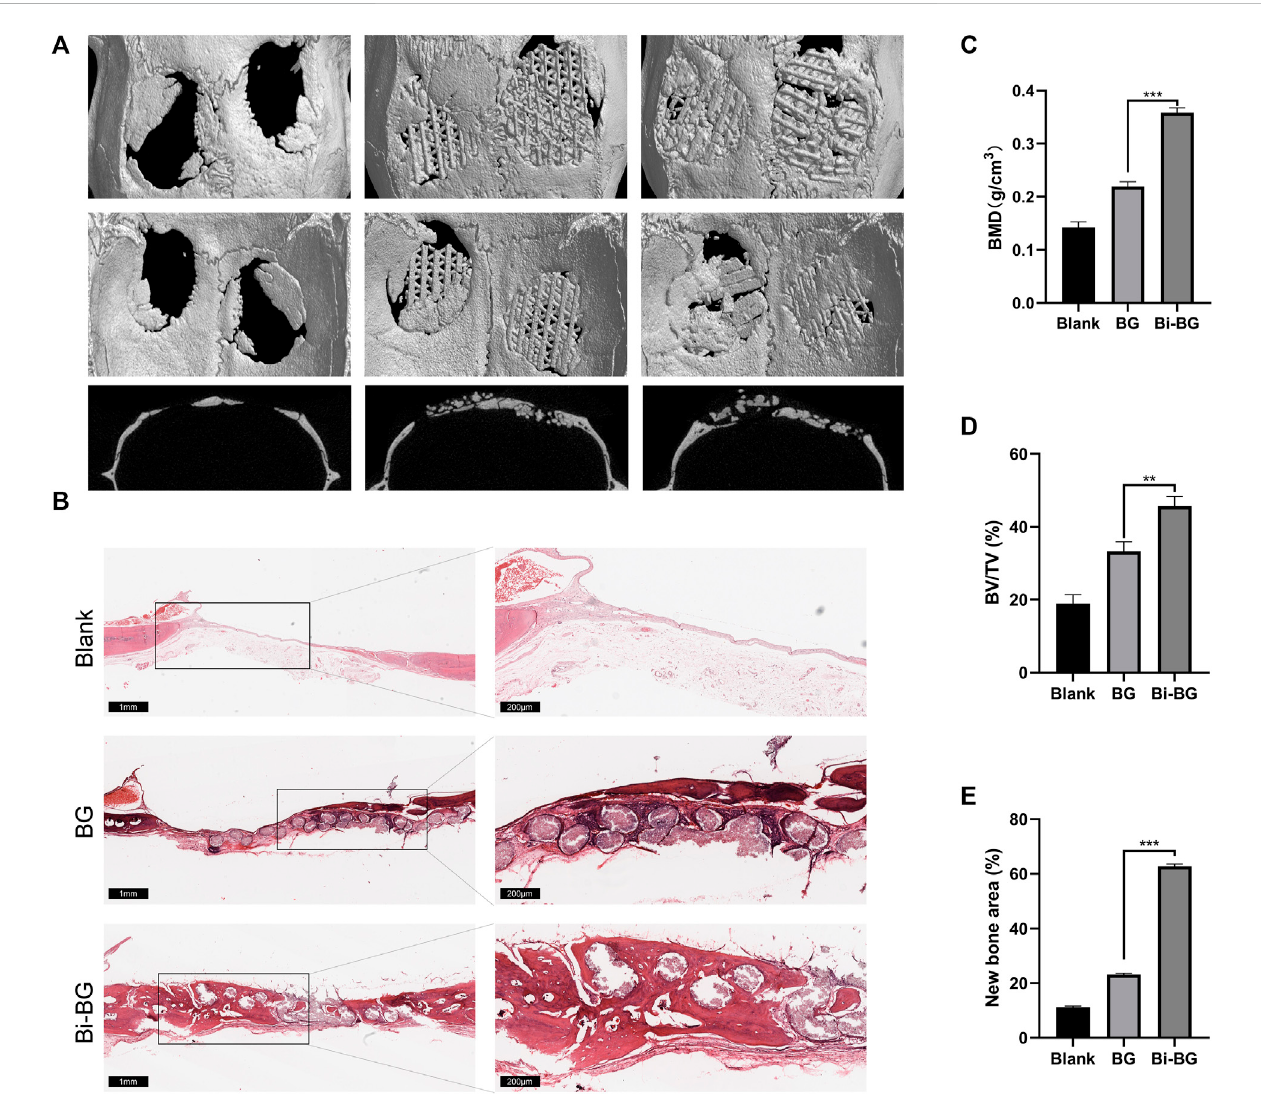
FIGURE 5 In vivo bone regeneration of Bi-BG scaffolds. (A) 3D reconstruction and sagittal Micro-CT imagesof the repaired skulls and (B) HE staining images of the blank, BG and Bi-BG groups after 8 weeks ’ implantation. (C) BMD, (D) BV/TV, and (E) new bone area of each